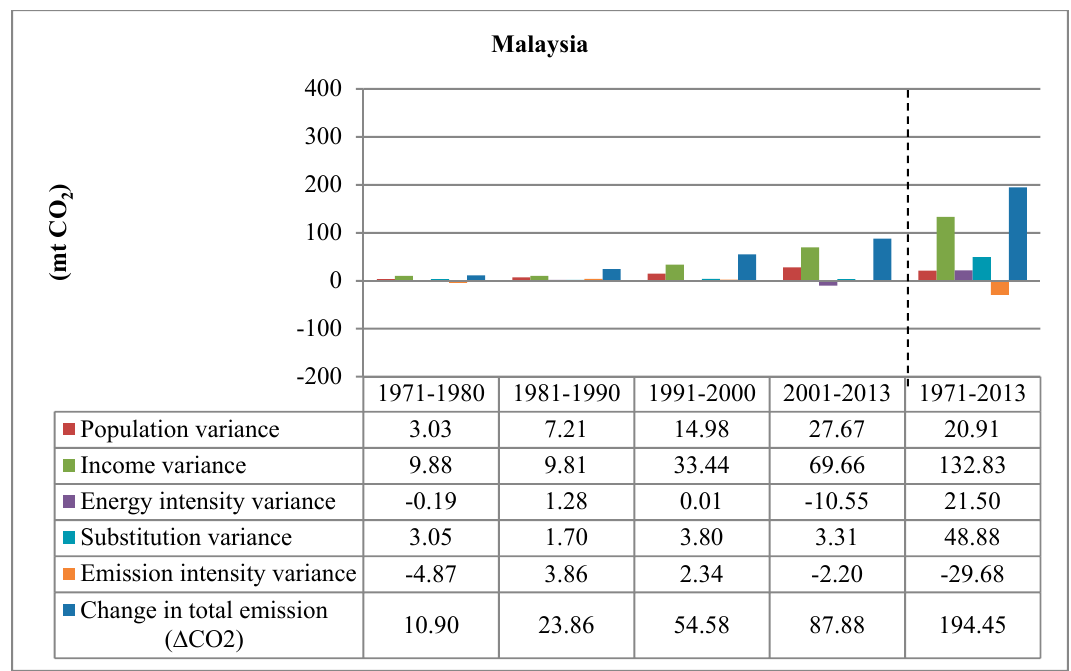
Figure 11. Decomposition results of CO 2 emissions in Malaysia.